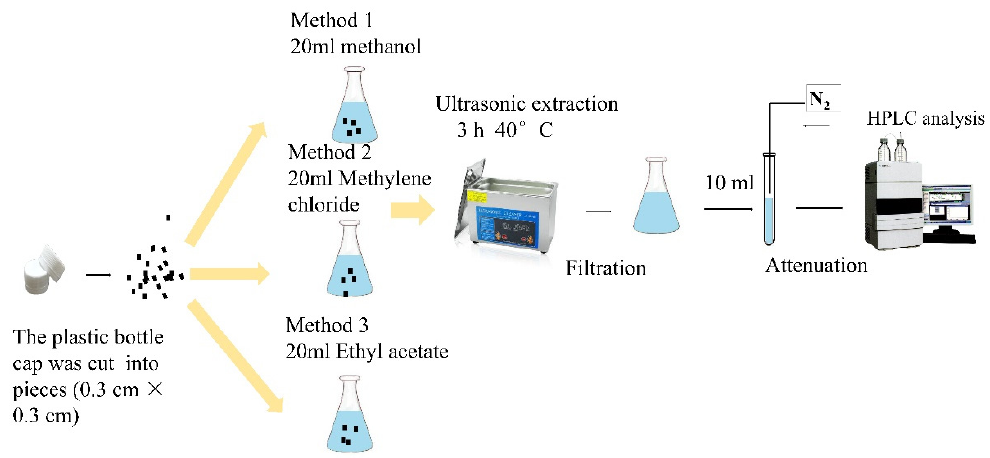
Figure 2. Schematic flow for analyzing the initial contents of the antioxidant in active plastic caps.